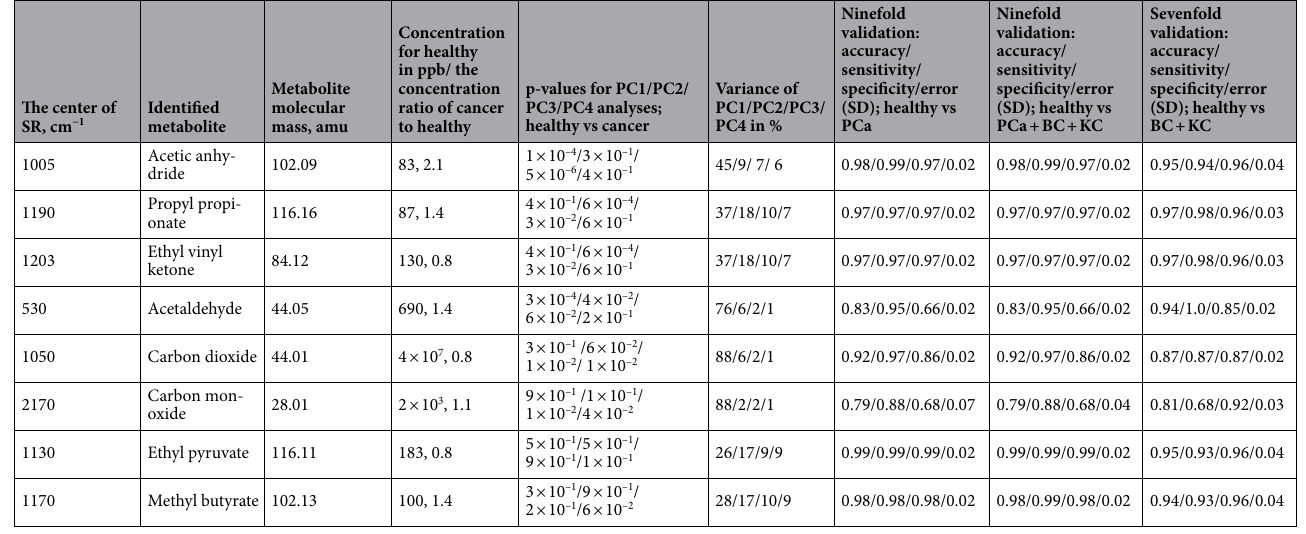
Table 1. SRs where average (over different cancer groups) absorption spectra differ from the healthy group. Columns 5–6: results of unsupervised PCA + ANOVA, columns 7–9: results of supervised k-fold validation for different cancer